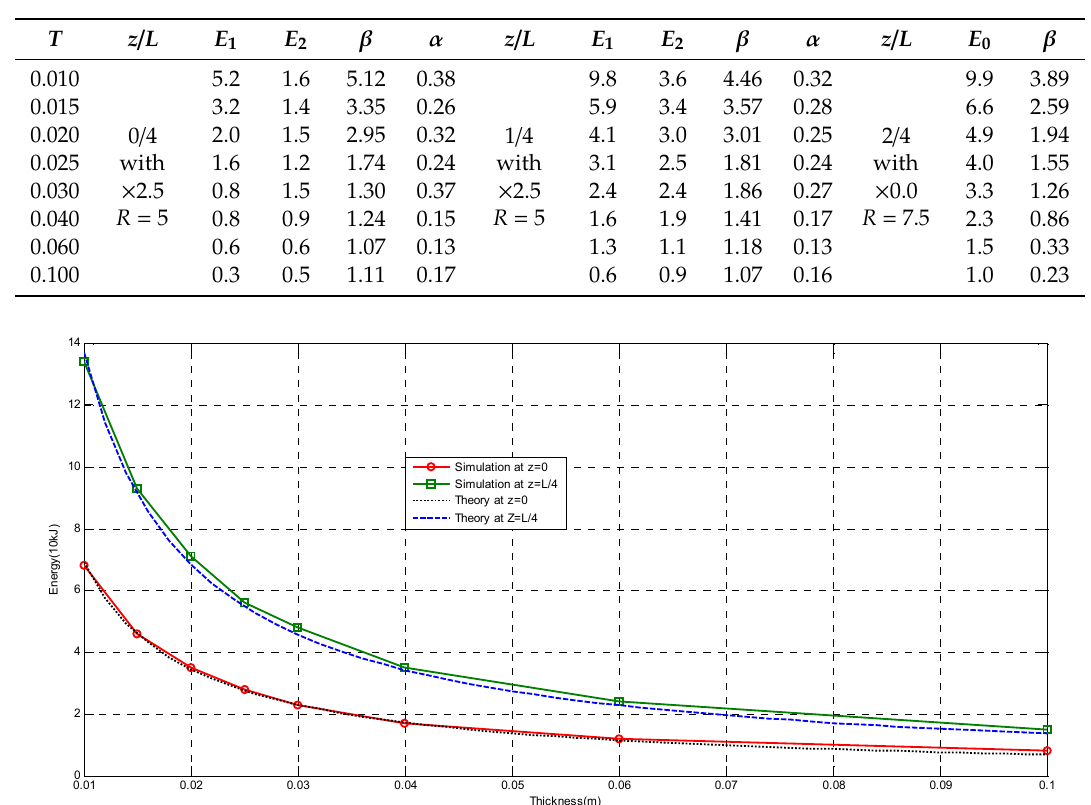
Figure 28. The comparison between Equations (14) and (18).